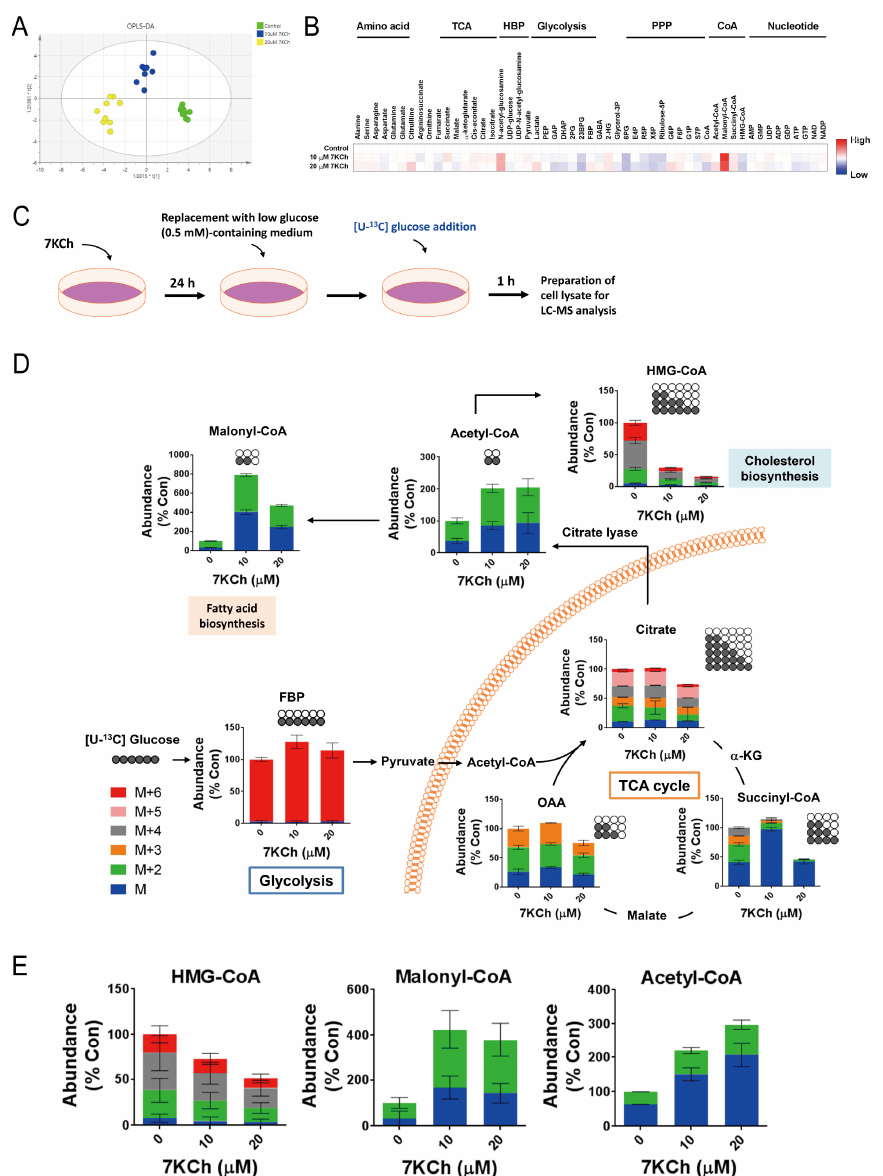
Figure 4. The reprogramming of cardiomyocytic metabolism and malonyl-CoA accumulation is induced by 7KCh. ( A , B ) The HL-1 cells were treated with the vehicle (Control) or with the indicated concentrations of 7KCh for 24 h, and subsequently, harvested for LC-MS/MS analysis in the electrospray ionization (ESI) negative ion mode. The OPLS-DA score plot ( A ) and the heatmap showing metabolites with significant differences between the 7KCh treatment group versus the control ( B ) are shown. The percent relative abundance is color-coded. Data are mean ± SD of six experiments. ( C ) A schematic diagram of the 7KCh treatment and [U- 13 C] glucose labeling procedure is shown. HL-1 ( D ) and AC16 ( E ) cells were treated with the vehicle or with 10 or 20 µ M 7KCh for 24 h, labeled with [U- 13 C] glucose for 1 h, and harvested for MS and isotopologue analysis. Distribution of M (blue), M+2 (i.e., with 2 13 C atoms; green), M+3 (orange), M+4 (grey), M+5 (pink) and M+6 (red) isotopologues of metabolites were analyzed using the liquid chromatography/time-of-flight/mass spectrometry (LC-TOF-MS) system. The abundances of the selected metabolites (malonyl-CoA, acetyl- CoA, HMG-CoA, FBP, citrate, succinyl-CoA, and OAA) are expressed as the percentage relative to the 0 µ M 7KCh treatment group ( Con ). The histograms are mapped onto the biochemical pathways ( D ). ( E ) The levels of HMG-CoA, malonyl-CoA and acetyl-CoA in AC16 cells treated with the indicated concentrations of 7KCh are shown. Data are mean ± SD of six